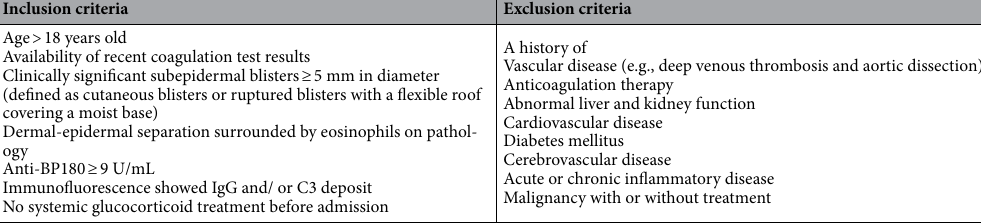
Table 1. Inclusion and exclusion criteria for a cross-sectional study of BP